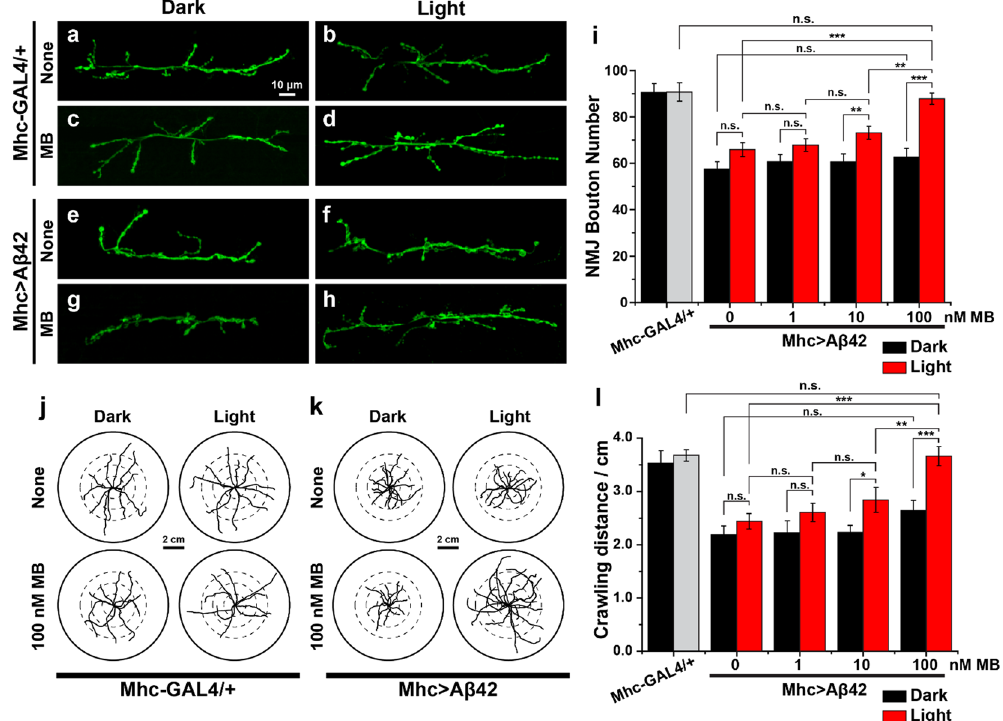
Figure 3. Photo-excited MB restores the phenotypes of A β 42 toxicity in vivo model system. ( a–h ) The images of the NMJ boutons on muscle 6/7 of A3. Indicated genotype flies were incubated with or without 100 nM MB treatment under dark and red LED light. NMJ boutons were observed by HRP immunostaining. ( a , c ) NMJ of the Mhc- GAL4/ + control and ( e , g ) NMJ of the Mhc > A β 42 under dark condition; ( b , d ) NMJ of the Mhc-GAL4/ + control and ( f , h ) NMJ of the Mhc > A β 42 treated with or without 100 nM MB under red LED light. ( h ) NMJ morphology phenotype caused by A β 42 overexpression is rescued by photoexcited-MB. Scale bar: 10 μ m. ( i ) Effect of various concentration of MB on the total number of NMJ boutons on muscle 6/7 of A3. Indicated genotype flies were incubated with 0, 1, 10, and 100 nM concentration of MB under dark and red LED light conditions. ( j , k ) The diagram of the crawling path of the larvae on the plate. Diameter of inner-circles are 1.0 cm, 2.0 cm and 3.0 cm, respectively. ( j ) The crawling path of the Mhc-GAL4/ + control and ( k ) Mhc > A β 42 with or without 100 nM MB treatment under dark and red LED light. The locomotor phenotype in A β 42 overexpression is rescued by photoexcited MB. Scale bar: 2 cm ( l ) Quantification of crawled distance of larvae within 90 seconds. Indicated genotype flies were incubated with 0, 1, 10, and 100 nM concentration of MB under dark and red LED light conditions.